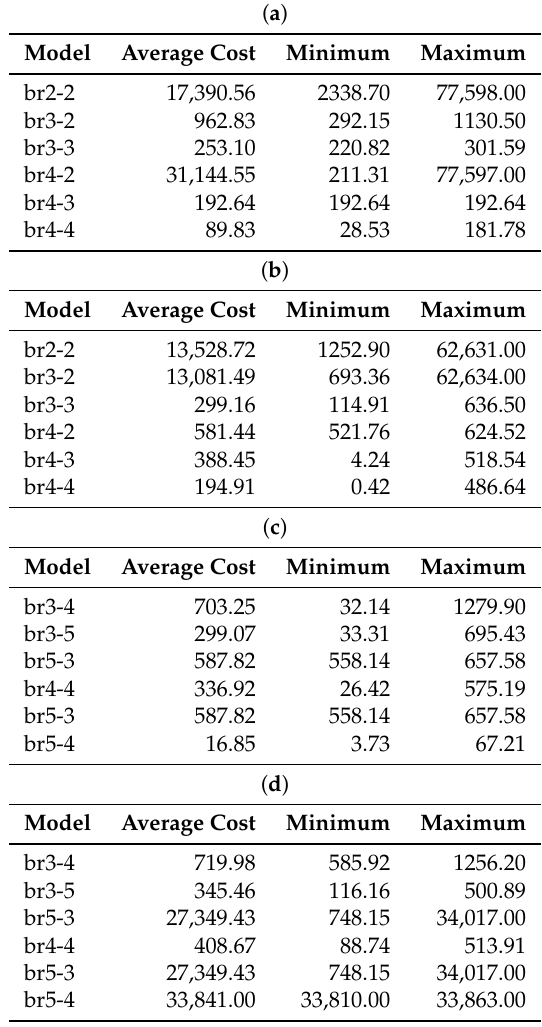
Table 4. Comparison of the identification residuals: ( a ) for the networks of (i) that model T c x , ( b ) for the networks of (i) that model T c y , ( c ) for the networks of case (ii), and ( d ) for the networks of case